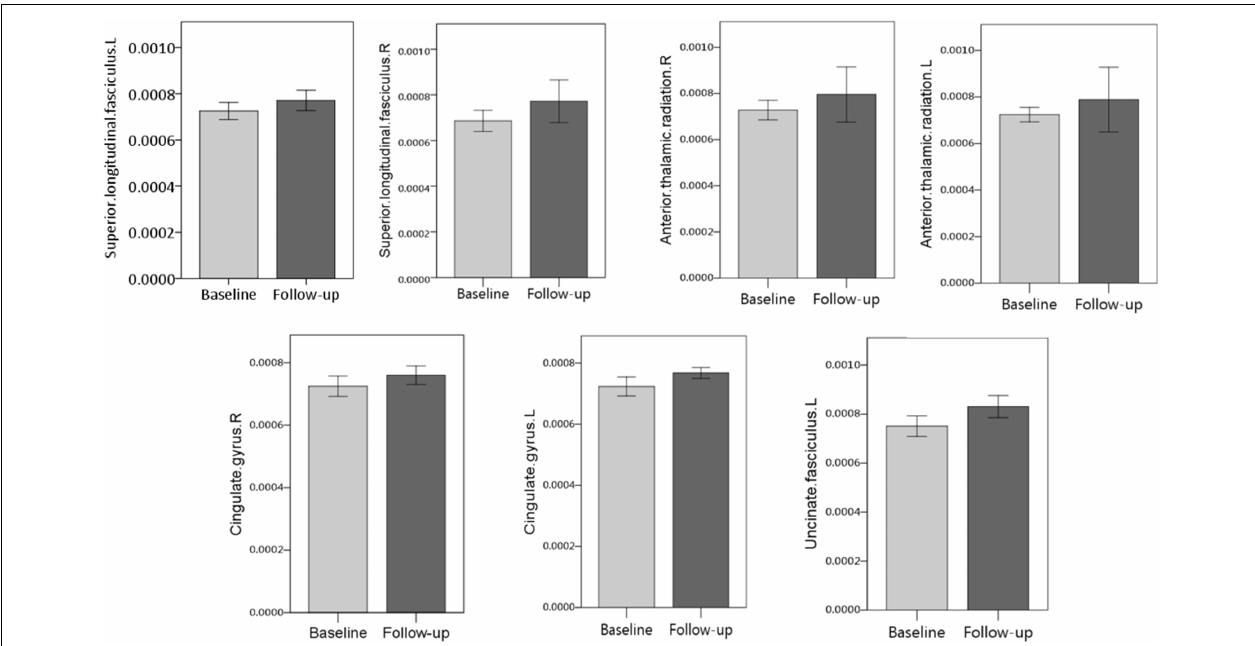
FIGURE 4 | Detailed MD changes (FWE correction, P < 0.05) in overlapping white matter (WM) tracts between asymptomatic carriers and patients with CJD are shown. Overlapping patterns were detected in the bilateral superior longitudinal fasciculus, bilateral thalamic radiation, bilateral cingulate gyrus, and left uncinate